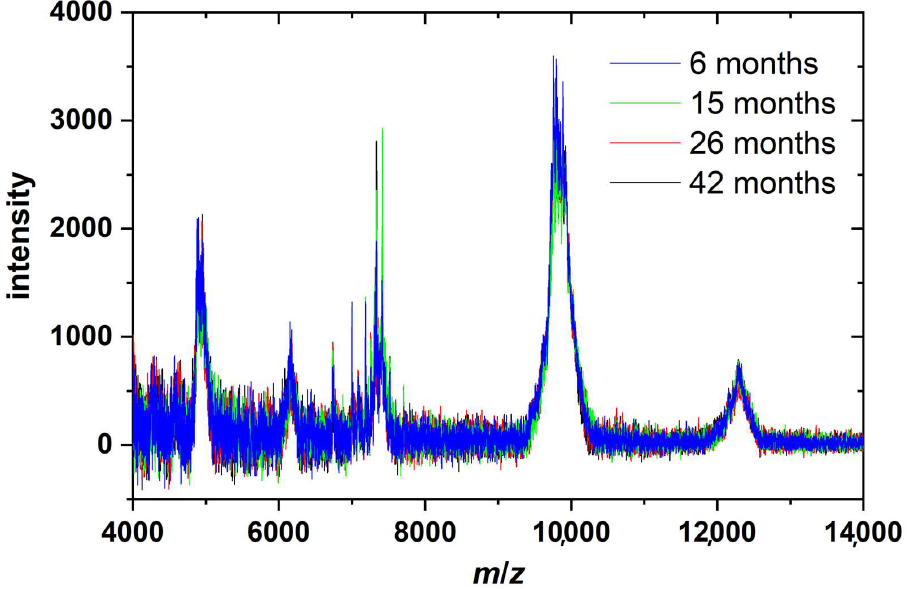
Figure 4. MALDI-TOF mass spectra of all four staple sets that differ in age from 6 to 42 months.